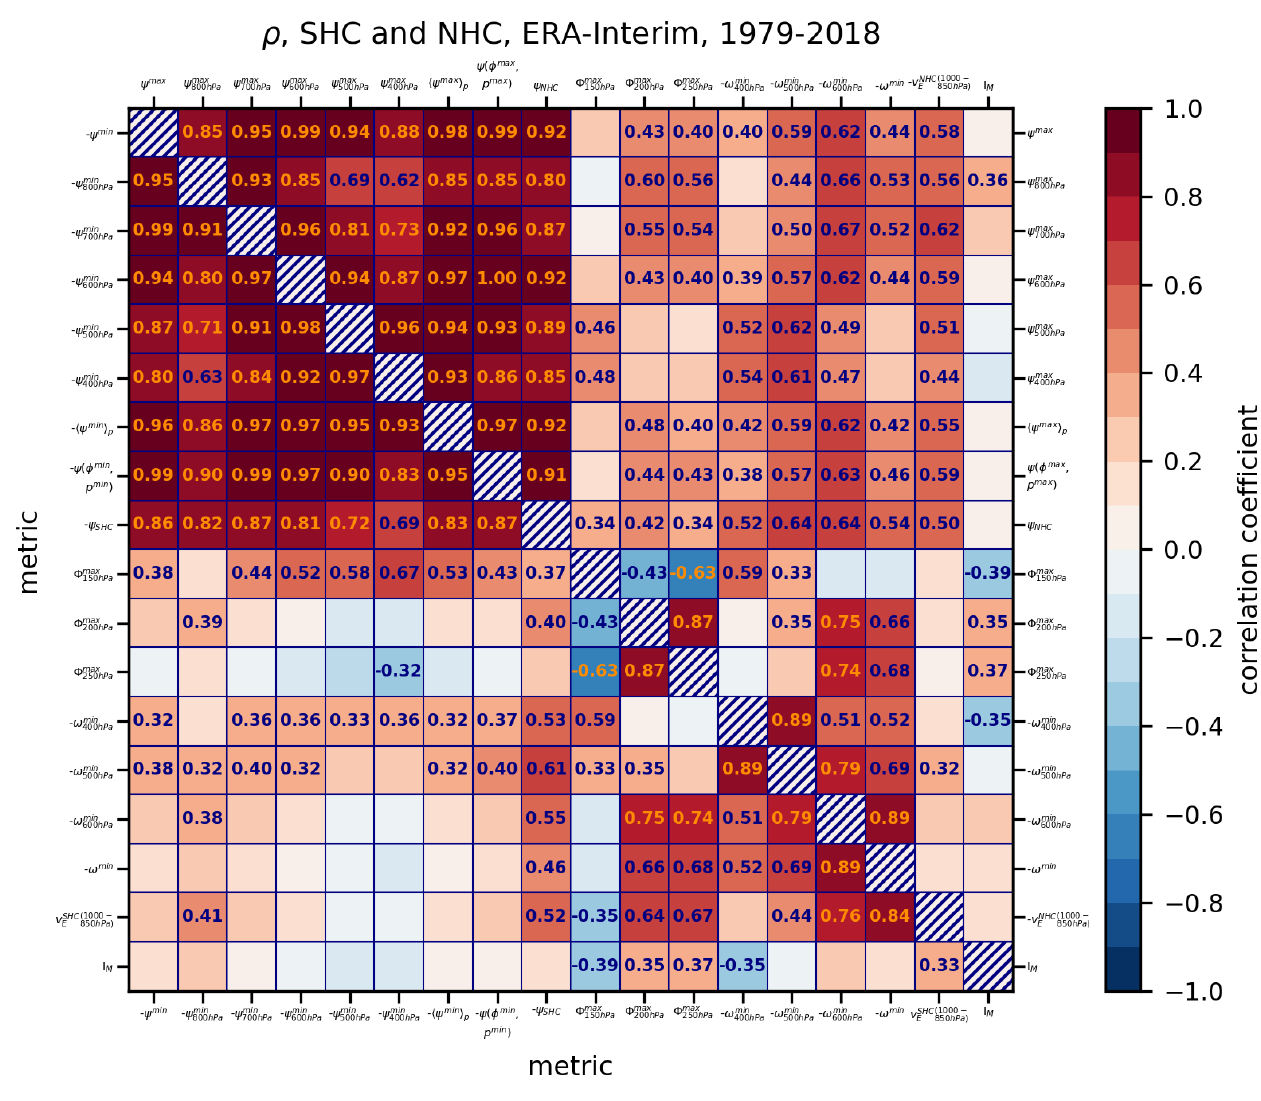
Figure A8. As in Fig. 5, but for